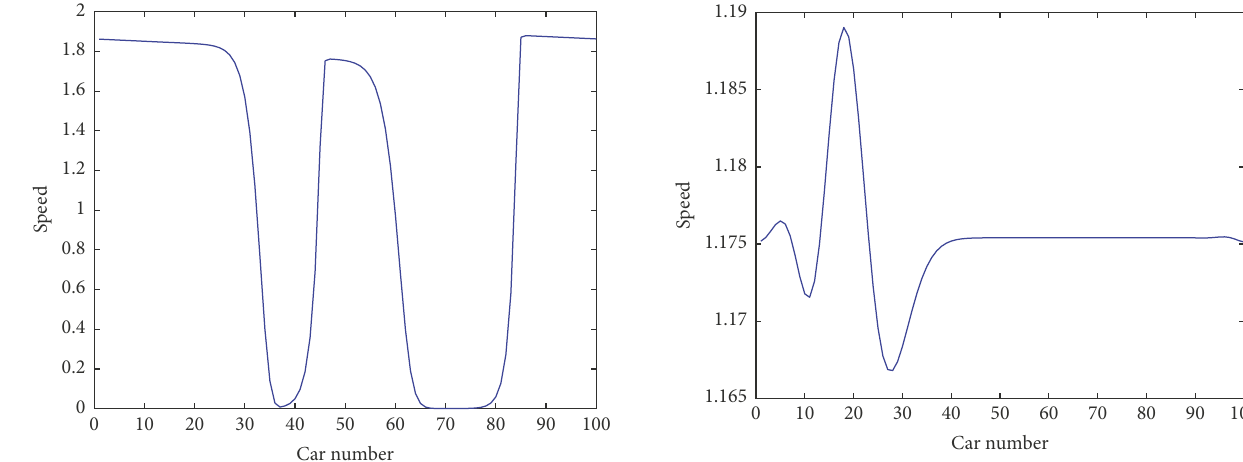
Figure 7: Speed profiles for DSDM with 𝛼 = 0.4 , 𝑇 𝑠 = 1.5 at 𝑡 =